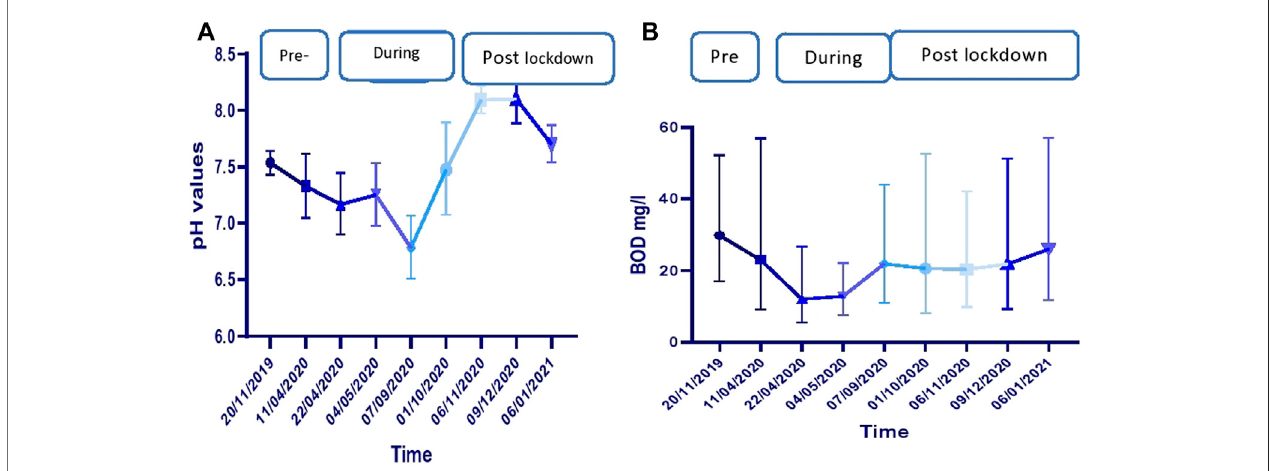
FIGURE 3 | Time series plot for the pH and BOD values during the pandemic in Yamuna river.